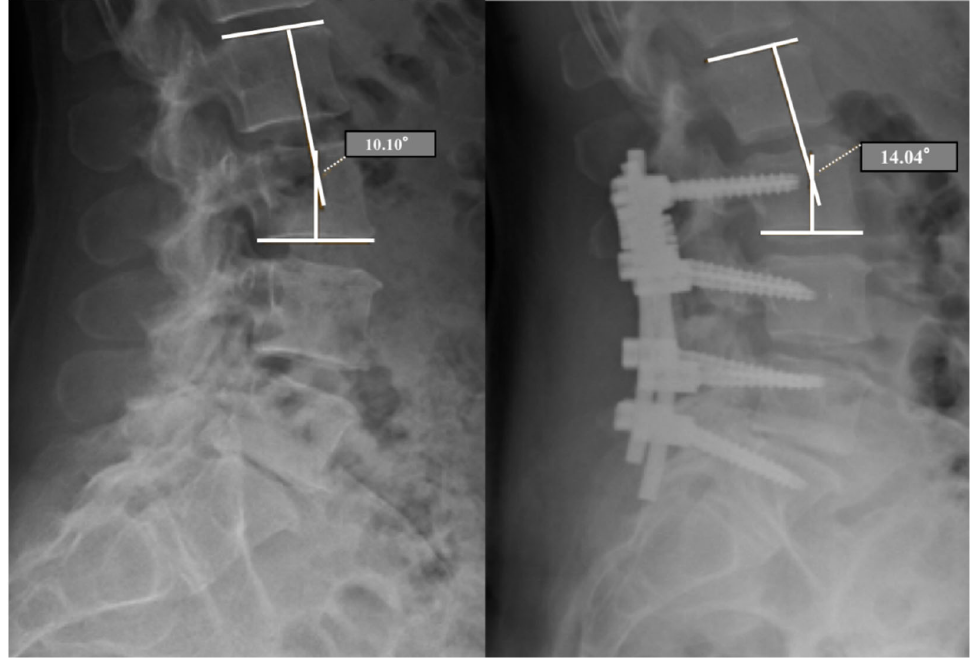
Figure 2. Preoperative and postoperative (6 months) radiological evaluation of the segmental angle (SA) between the dynamized level (DL) and adjacent level (AL). (SA) between the dynamized level (DL) and adjacent level